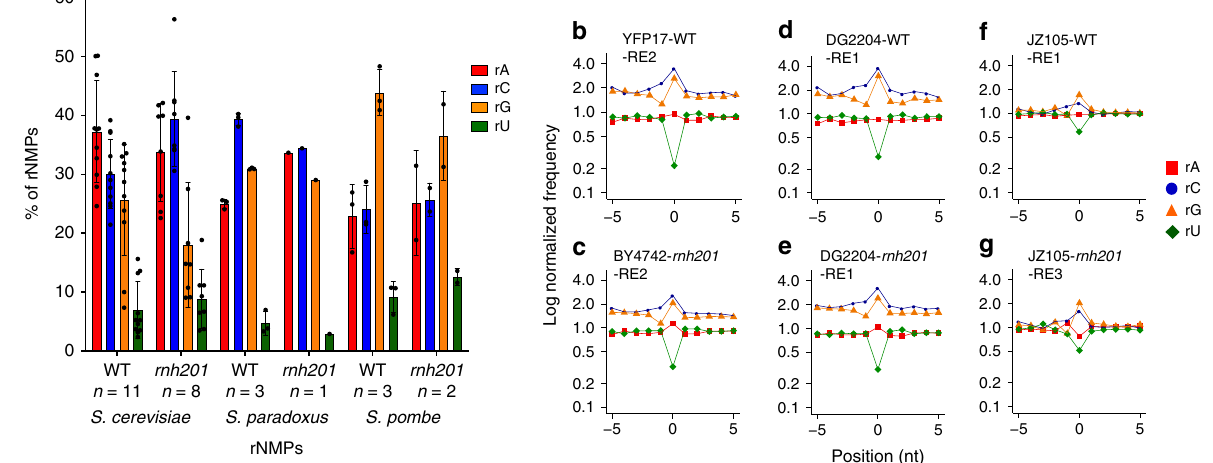
Fig. 1 Identity and frequency of rNMP types in the mitochondrial yeast genome. a Bar graph with corresponding data points showing percentage of rA, rC, rG, and rU found in mtDNA of WT or rnh201 Δ strains of S. cerevisiae , S. paradoxus , and S. pombe . Mean, standard deviation, and number of libraries ( n ) analyzed for each genotype are shown. b – g Zoomed-in plots of normalized nucleotide frequencies relative to mapped positions of sequences from mitochondrial ribose-seq libraries. Plots derived from example libraries are shown for S. cerevisiae b WT (YFP17-WT-RE2-FS146) and c rnh201 Δ (BY4742- rnh201 -RE2-FS138), S. paradoxus d WT (DG2204-WT-RE1-FS108) and e rnh201 Δ (DG2204- rnh201 -RE1-FS130), and S. pombe f WT (JZ105-WT-RE1-FS94) and g rnh201 Δ (JZ105- rnh201 -RE3-FS135). Position 0 is the rNMP, − and + positions are upstream and downstream dNMPs, respectively, normalized to the A, C, G, and T content in the corresponding yeast species. Red square, A; blue circle, C; orange triangle, G; and green rhombus,